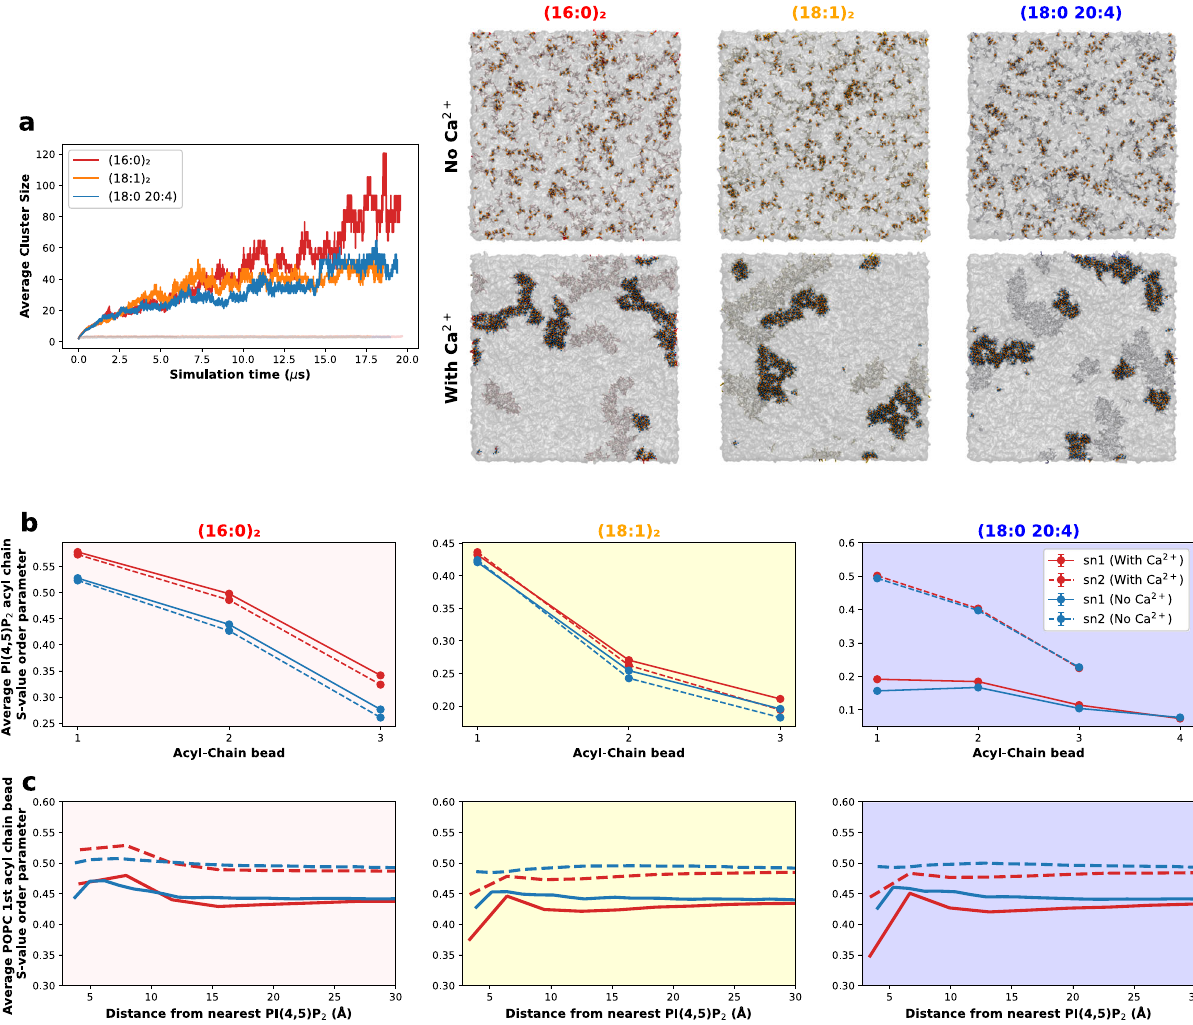
Fig. 5 CG MD simulations showcase the impact of acyl-chain composition on PI(4,5)P 2 and PI(4,5)P 2 nanodomain biophysical properties. a Average PI(4,5)P 2 cluster size over the course of the simulation for the three acyl-chain compositions studied, both in the presence and absence of calcium. Final simulation snapshots of the large membrane systems are also shown. PI(4,5)P 2 lipid headgroups are depicted in gray, with the phosphates discriminated in orange. PI(4,5)P 2 acyl chains are colored according to the corresponding color code. Ca 2 + ions are represented in blue. The bulk POPC lipids are represented by the translucent gray surface. b PI(4,5)P 2 acyl-chain S-value order parameter for all acyl-chain beads of each composition, in the presence (red) and absence (blue) of calcium. c Dependency of the S-value order of POPC ’ s fi rst acyl-chain bonds on the distance from the nearest PI(4,5)P 2 molecule, in the presence and absence of